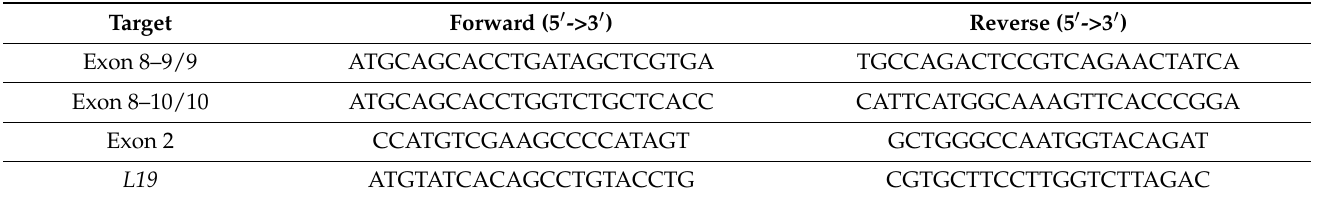
Table 1. Primers’